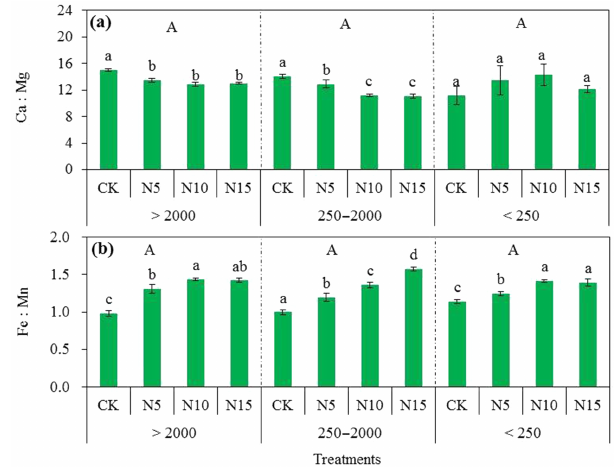
Figure 3. The ratio of (a) exchangeable Ca:Mg and (b) available Fe:Mn as influenced by N addition (0 [CK], 5 [N 5 ], 10 [N 10 ], and 15 [N 15 ]gNm − 2 yr − 1 ) in soil aggregates. Data are represented as mean ± SE. Lowercase letters indicate significant differences be- tween N treatments within a soil fraction. The capital letters at the top indicate significant differences between soil aggregate sizes across N